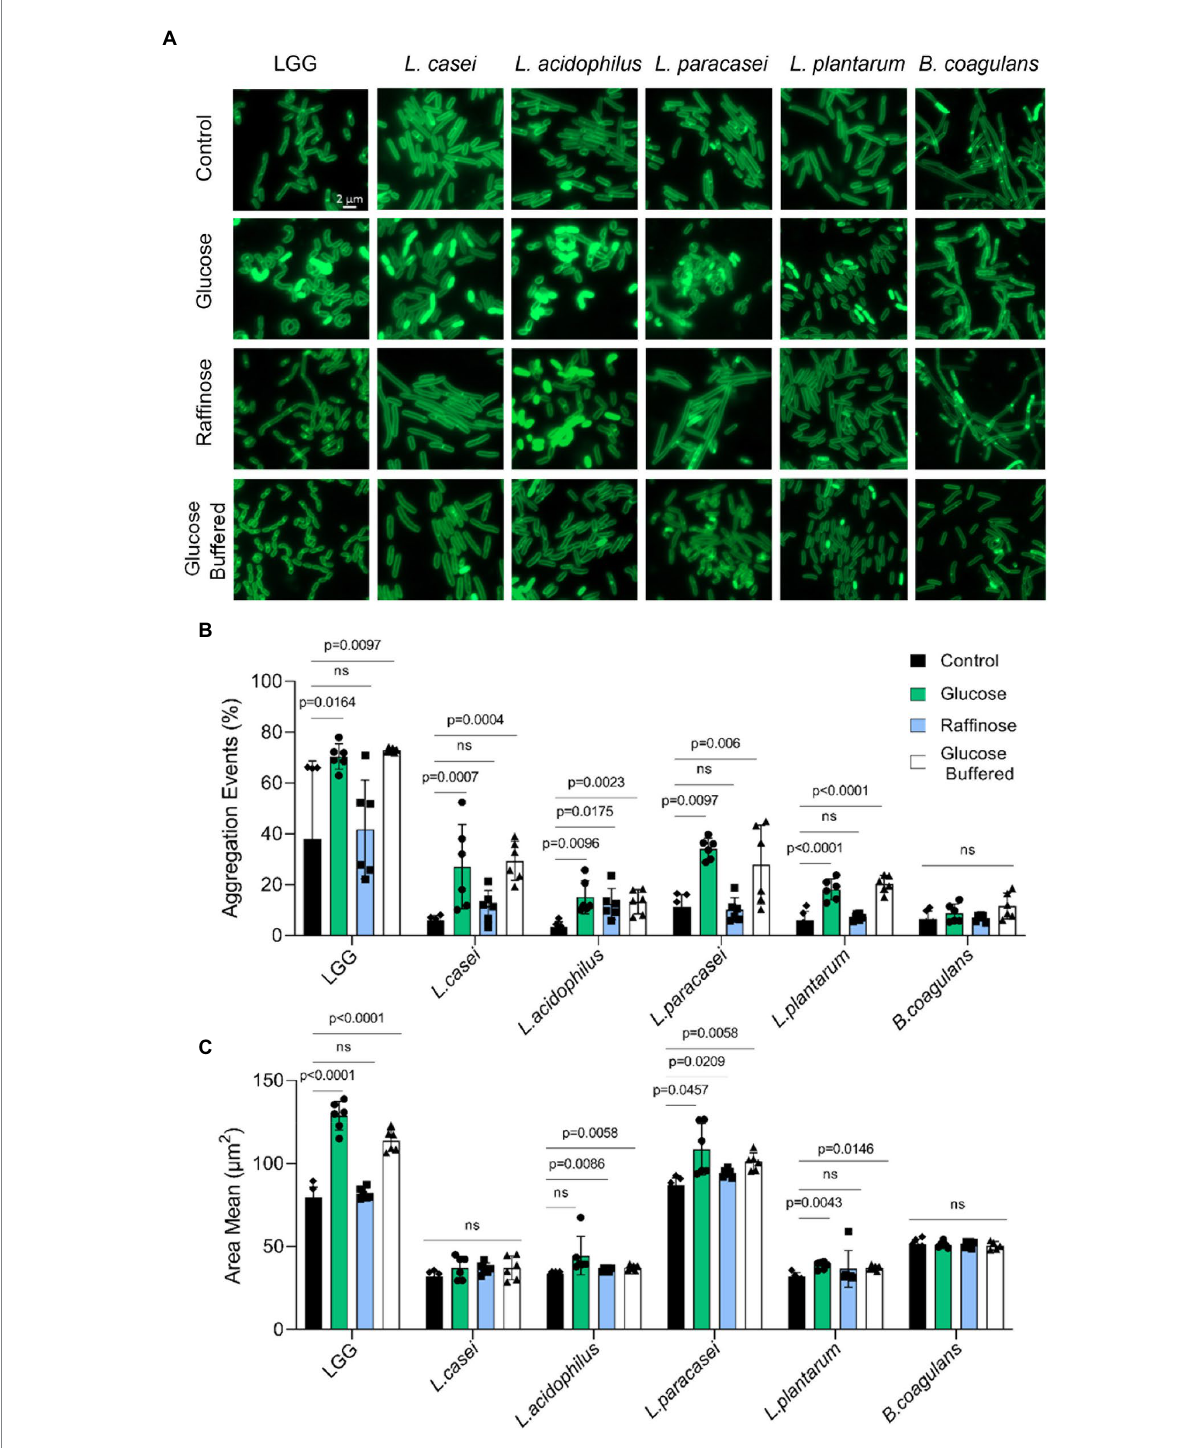
FIGURE 5 Carbohydrates specifically regulate microbial aggregation. (A) Fluorescence microscope images of cells from biofilm colonies that were grown on TSB medium (control), TSB medium supplemented with glucose and raffinose (1% W/V), and TSB medium supplemented with glucose (1% W/V) + buffer. Cells were stained using Green-membrane stain FM ™ 1–43FX. Biofilms were grown at 37 ° C in CO 2 enriched environment. Cells were imaged at 72 h post inoculation. The images represent 3 independent experiments, from each repeat at least 10 fields examined. Scale bar = 2 μ m. (B) Imaging Flow cytometry analysis of the number of aggregation events, population of the indicated species and (C) aggregate size-the mean of measured area of bacterial aggregates population. Cells were grown in liquid TSB medium supplemented with glucose (1% W/V), raffinose (1% W/V), and TSB medium supplemented with glucose (1% W/V) + buffer. Data were collected from overnight culture, and 20,000 cells were counted. Y-axis represents the % of aggregate events or area mean, and graphs represent mean ± SD from 2 independent experiments ( n = 6). Statistical analysis was performed using Brown-Forsythe and Welch’s ANOVA with Dunnett’s T3 multiple comparisons test. p < 0.05 was considered statistically